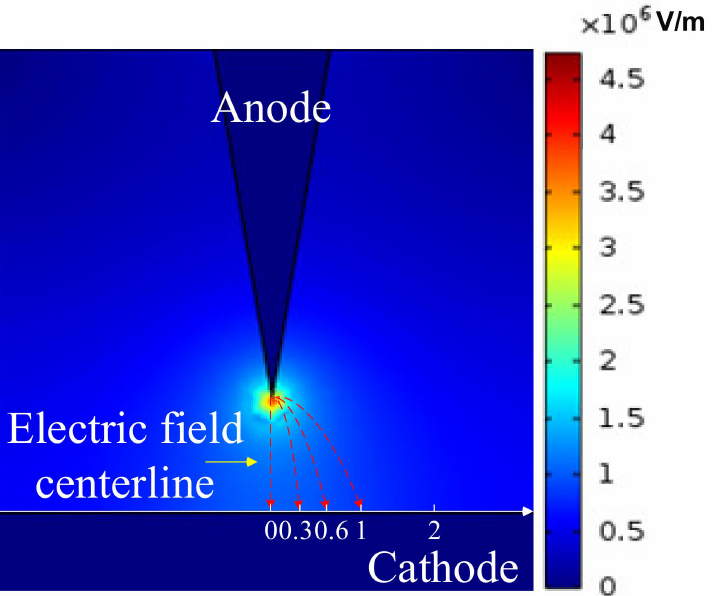
Figure 9. Electrical field intensity distribution of the needle plate electrode on the surface of the insulating